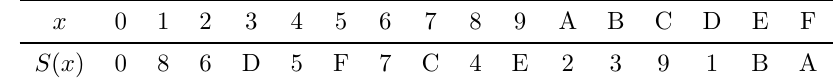
Table 3: The RoadRunneR